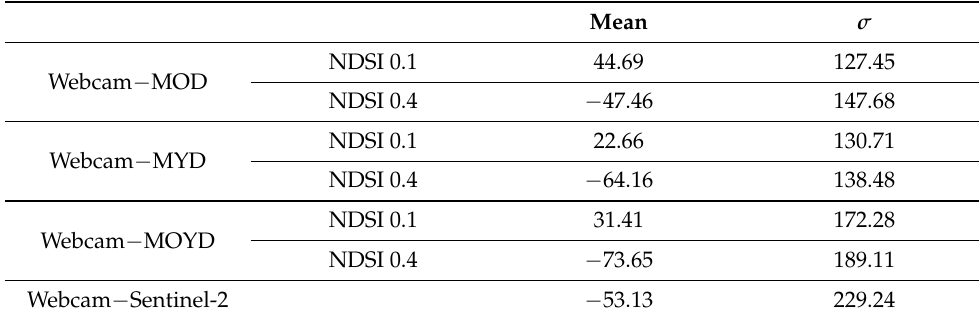
Table 2. Mean and standard deviation of differences between webcam regional snow line elevation (RSLE) and MODIS/Sentinel-2